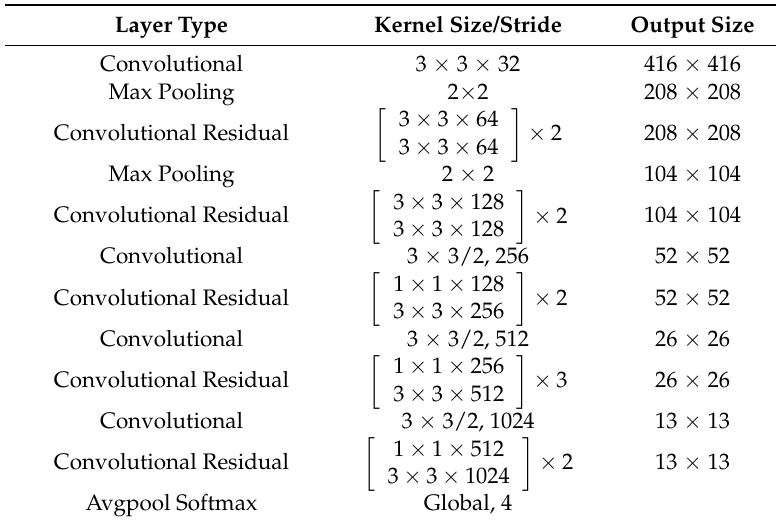
Table 1. Network